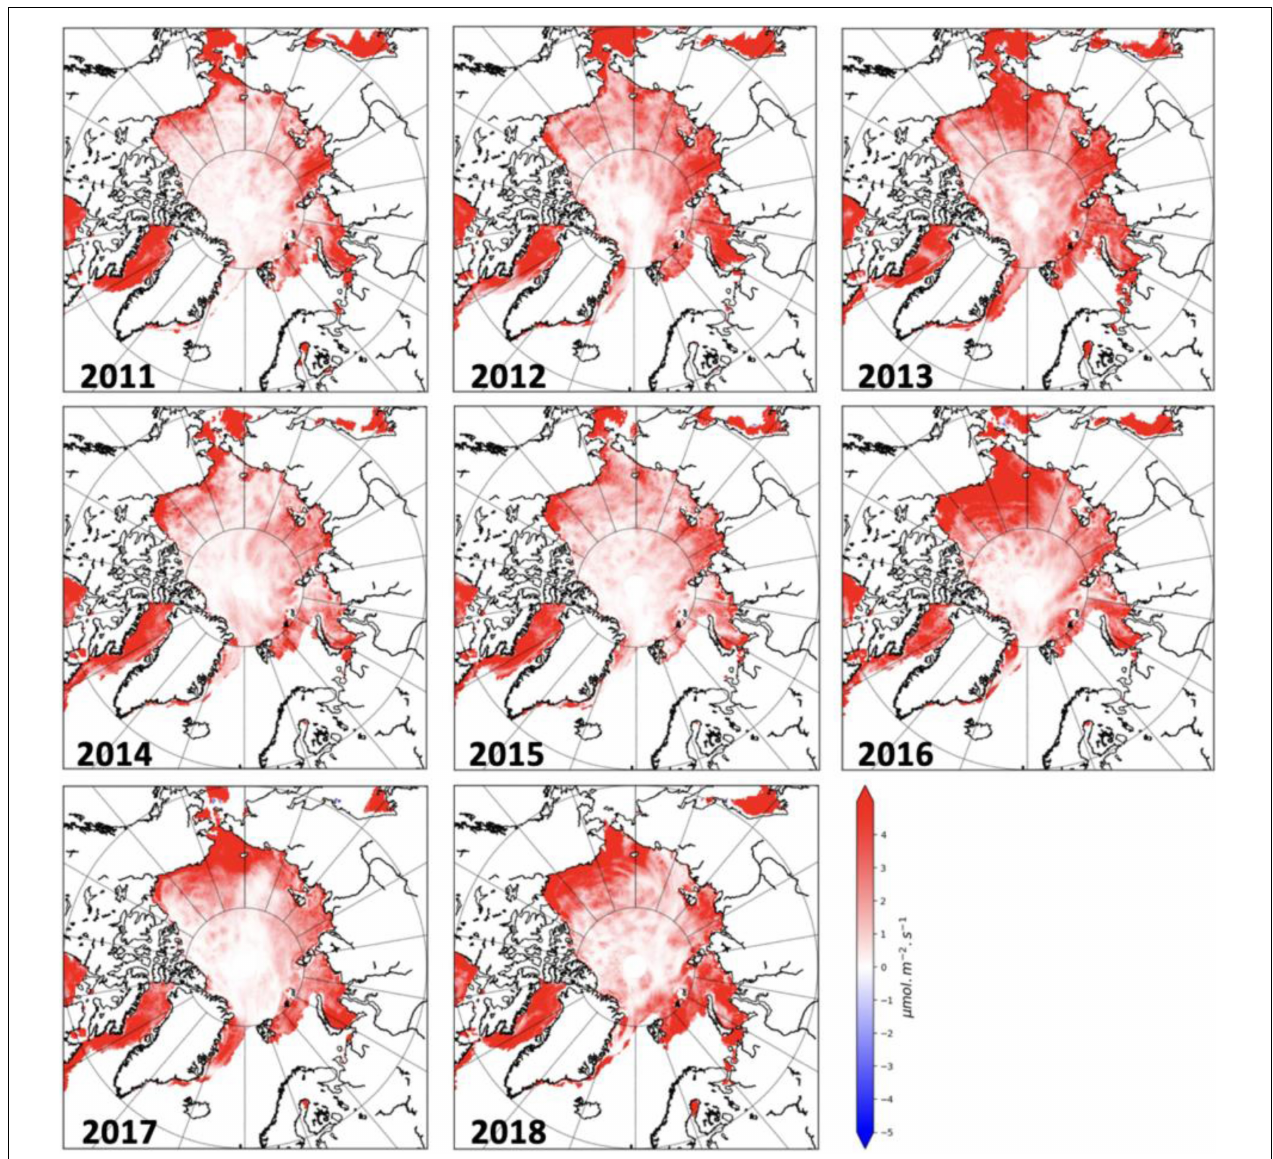
FIGURE 12 | Difference in April PAR between using a mean sea ice thickness per satellite pixel versus a fifteen ice thickness categories ITD heterogeneously distributed between 0 and 3h i , as described in section “Data Products,” and assuming a mean snow depth per grid cell.